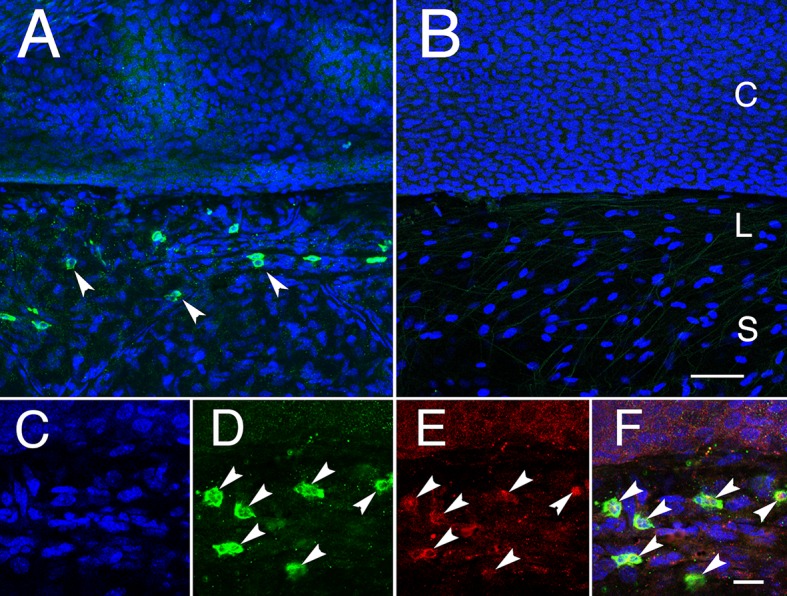
The surface of the eye was stained for POU6F2 and counter-stained with TOPRO-3 (A). The control section without primary antibody is shown in B. The limbus (L) is the transition between the cornea (C) and the sclera (S). In A, there are many cells stained for POU6F2 and all of these cells are localized to the limbus. C, D, E and F are higher magnification photomicrographs taken from the same region of a triple stained section. The section was stained with TOPRO-3, a nuclear marker (C), POU6F2 (D) and ABCB5 (E). F represents a merged image of the three channels. Stem cells are labeled by arrows in C, D and E. Photomicrographs in A and B are taken at the same magnification and the scale bar in B represents 50μm. Photomicrographs in C, D, E and F are taken at the same magnification and the scale bar in F represents 20 μm.